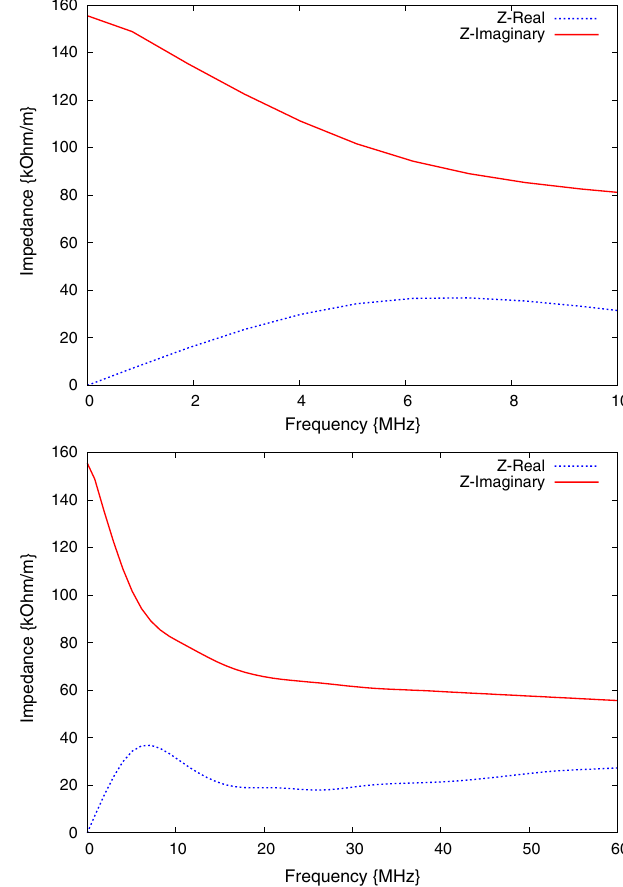
FIG. 3. Impedance of the SNS extraction kicker system used in simulations, based on